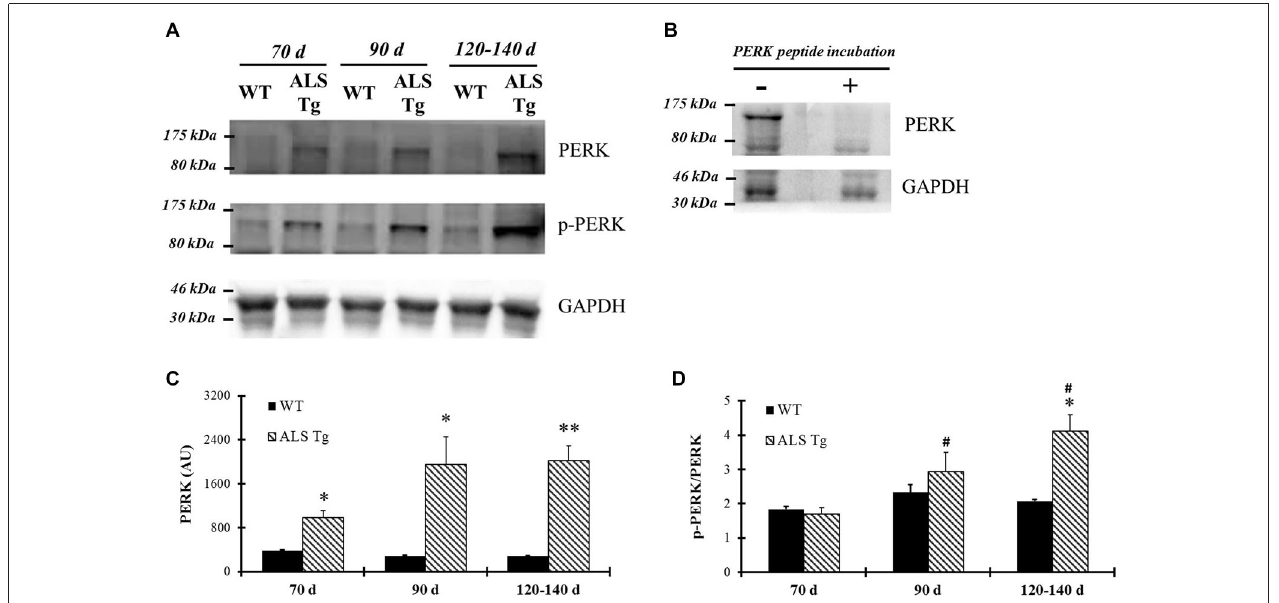
pre-symptomatic (90d; n = 5 each for WT and ALS-Tg), and symptomatic (120–140d; n = 3 each for WT and ALS-Tg) mice. (B) Protein samples were incubated either with or without PERK peptides and then PERK protein levels were detected using western blots technique. (C) Analysis of average arbitrary units (AU) obtained by densitometry for PERK. (D) Analysis of average ratio of phospho-PERK to total PERK. Data in (C) and (D) are presented as mean ± S.E; *, p < 0.05; **, p < 0.01 WT vs. ALS-Tg in the same age group. # p < 0.05 vs.